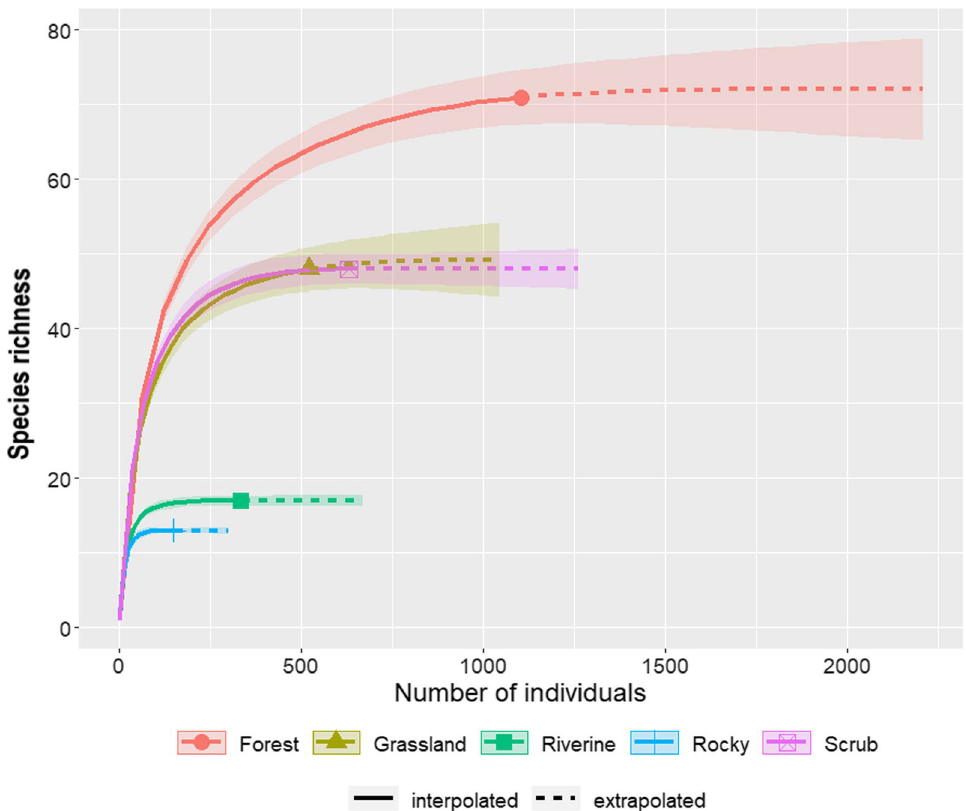
Fig. 3 Individual-based rarefaction and extrapolation curves of bird species for the studied vegetation or land use types. The shaded areas are the 95% confidence intervals of species